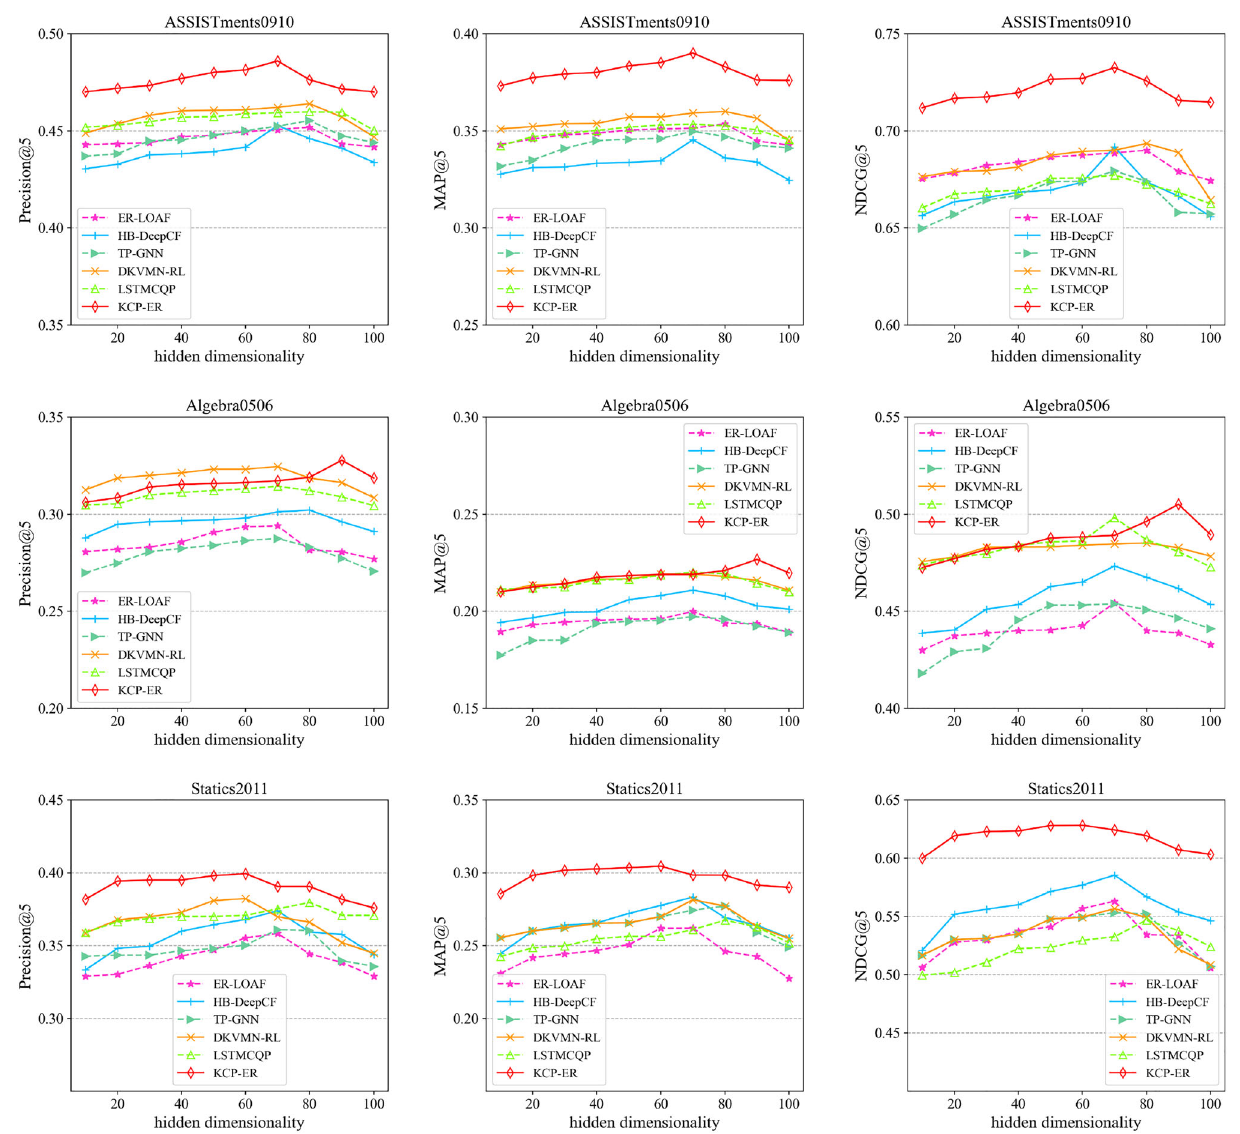
Fig. 6 Recommendation performance of TERD with hidden dimensionality on three datasets